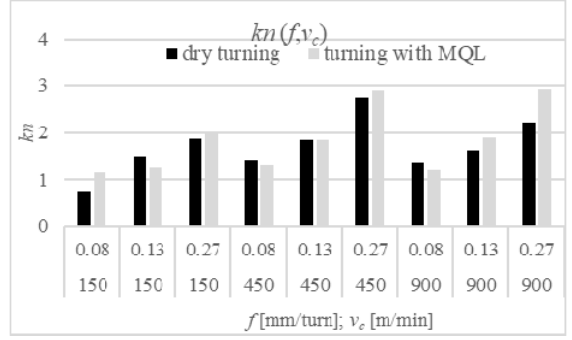
Figure 19. Constancy factor of cutting force Fc in alumi– nium composite turning with polycrystalline diamond tool.